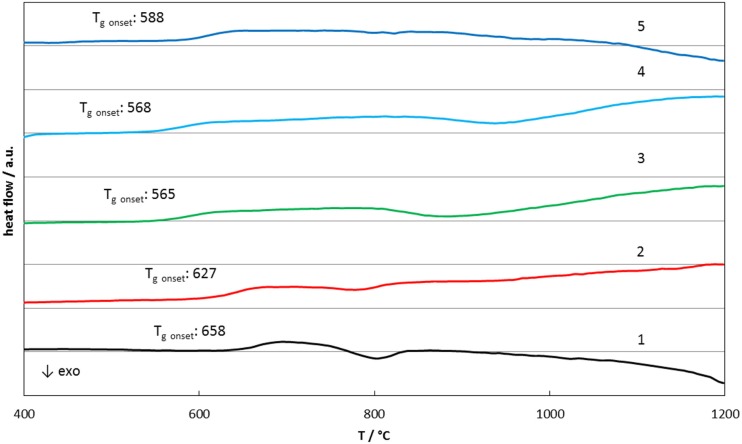
Differential scanning calorimetry results of glasses 1–5.